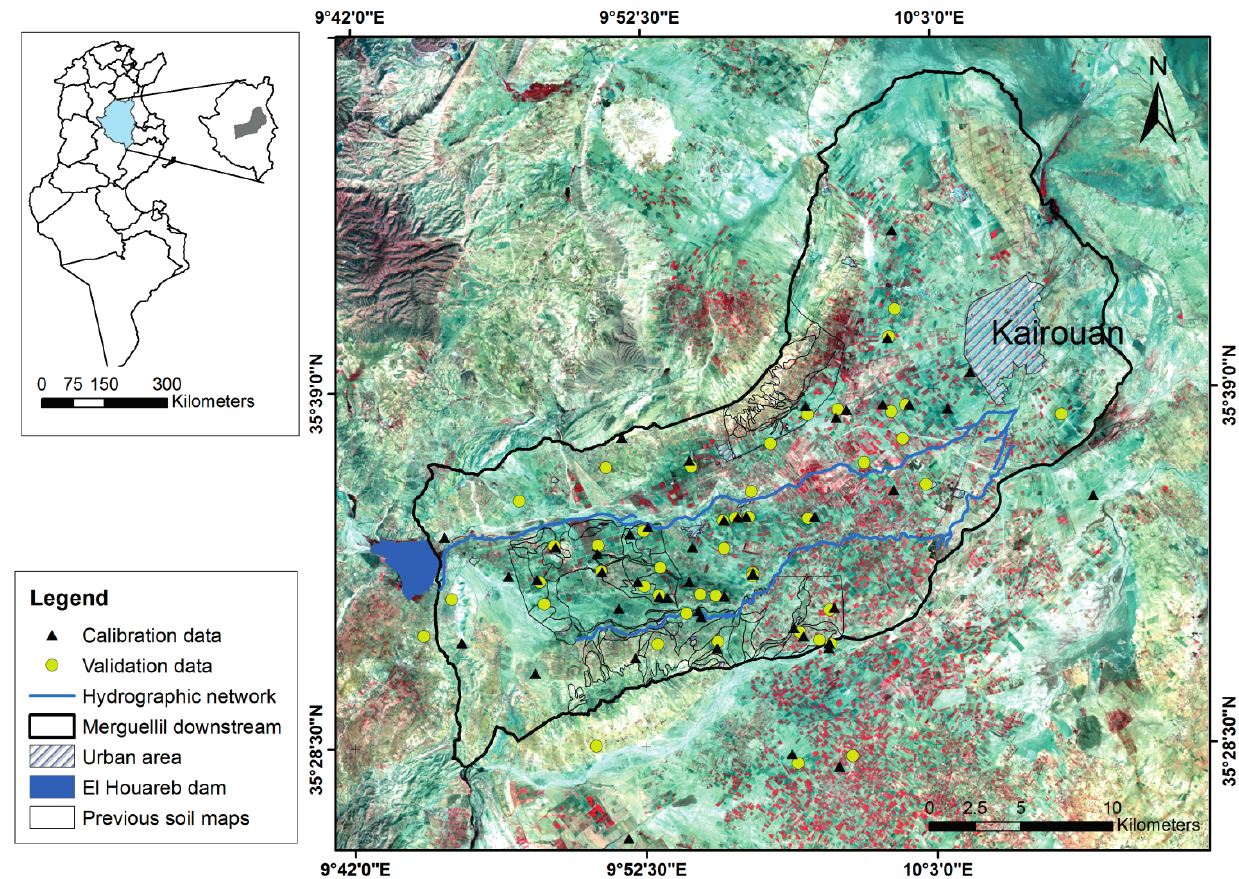
Figure 1. Study area and location of calibration and validation